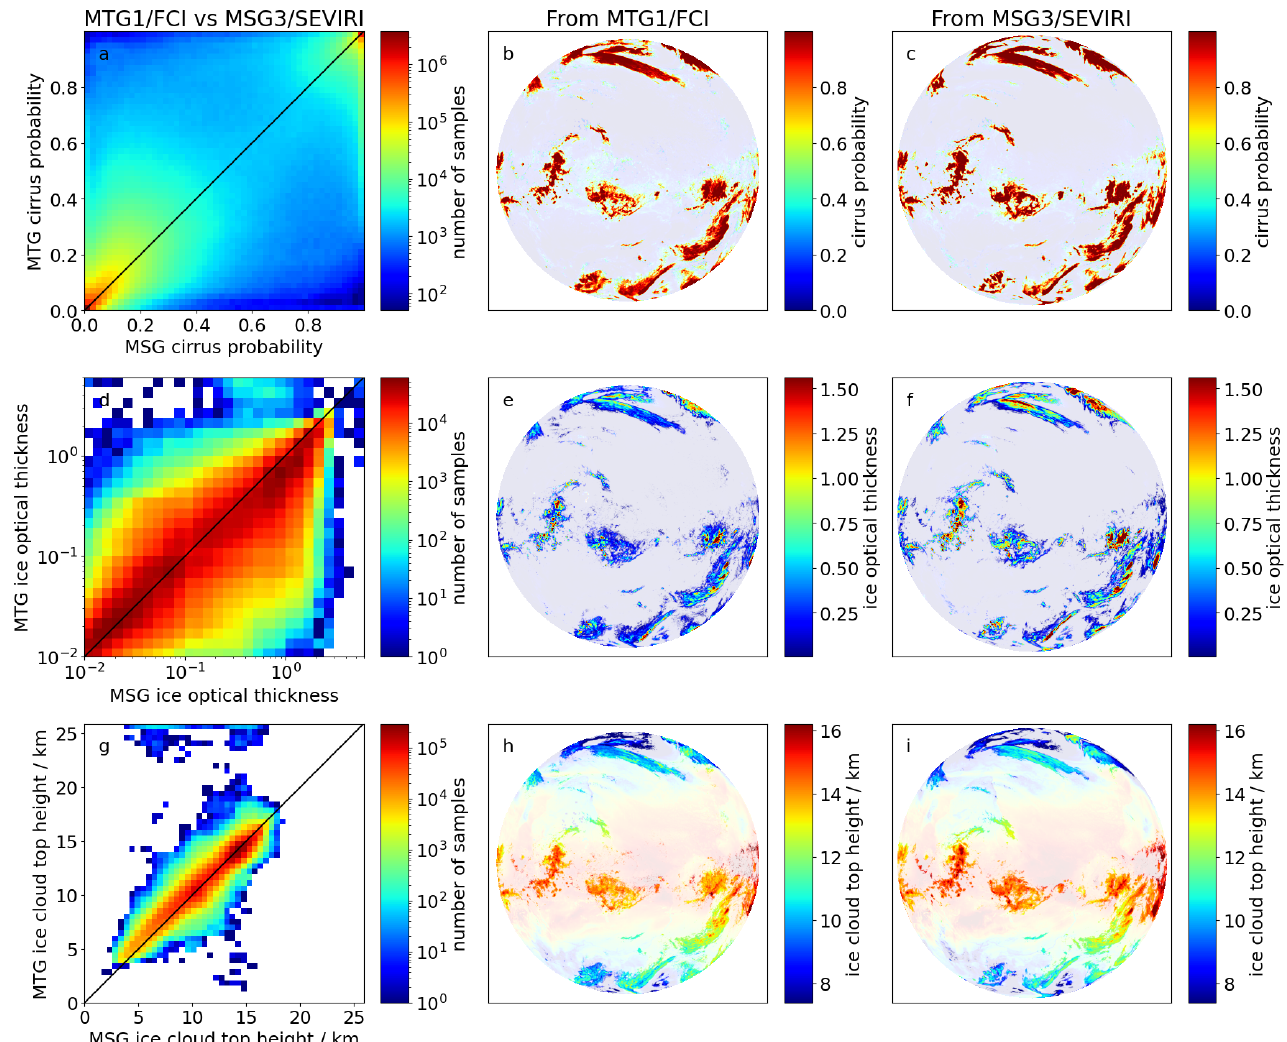
Figure 8. Application of the CiPS retrievals for the ( a – c ) cirrus probability, ( d – f ) the ice optical thickness, and ( g – i ) the ice cloud top height. Results are shown using ( b , e , h ) MTG1/FCI test data, and ( c , f , i ) MSG3/SEVIRI observations, both after applying moderate SBAFs with respect to MSG2/SEVIRI and the re-analysis GSICS-correction for MSG3/SEVIRI for a scene on 20 September 2017 at 12:00 UTC. A mask was applied to the satellite images to show only the regions in which the cirrus cloud probability is larger than 0.62. ( a , d , g ) The CiPS products resulting from both satellite datasets are shown as two-dimensional histogram, with ( a ) including all pixels whereas ( d , g ) contain only samples for which the cirrus probability is larger than 0.62 according to both MTG1/FCI and